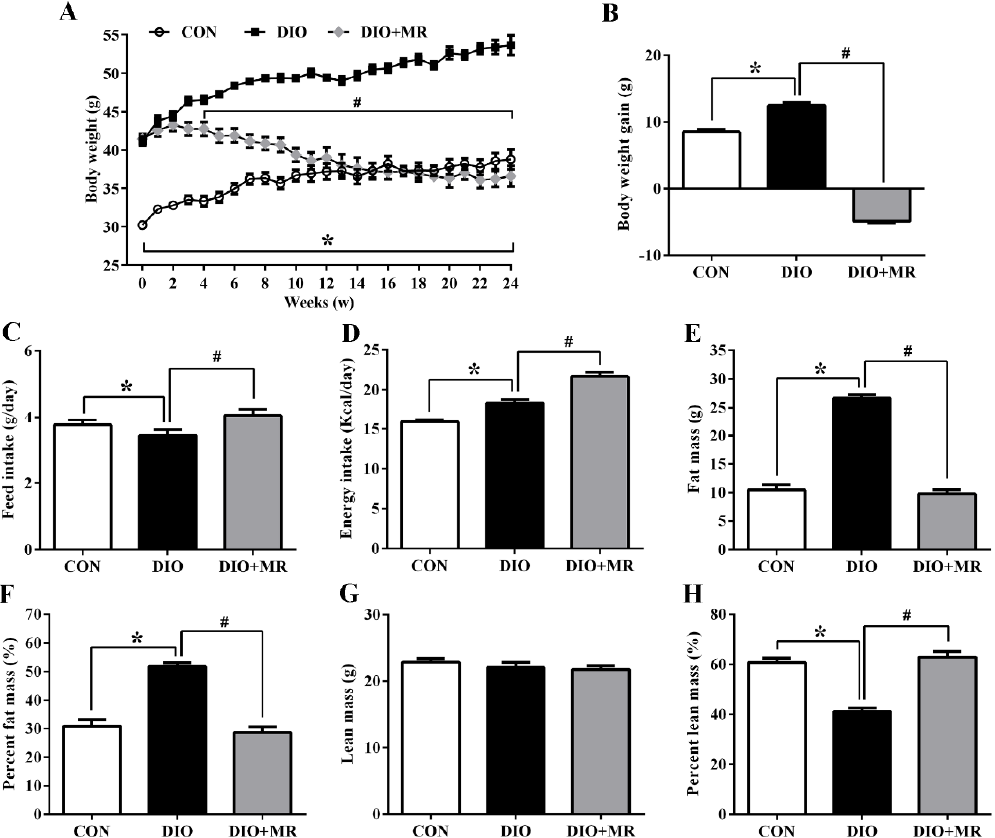
Figure 2. Effects of MR on body weight ( A ), body weight gain ( B ), feed intake ( C ), energy intake ( D ), fat mass ( E ), percent fat mass ( F ), lean mass ( G ), and percent lean mass ( H ) in obese mice. CON, control diet group; DIO, obese + high fat diet group; DIO + MR, obese + high fat with low-methionine diet group. Percent fat mass or percent lean mass = (fat mass/lean mass) ÷ body weight × 100%. All data are shown as mean ± SEM ( n = 10). * p < 0.05 versus CON; # p < 0.05 versus DIO.